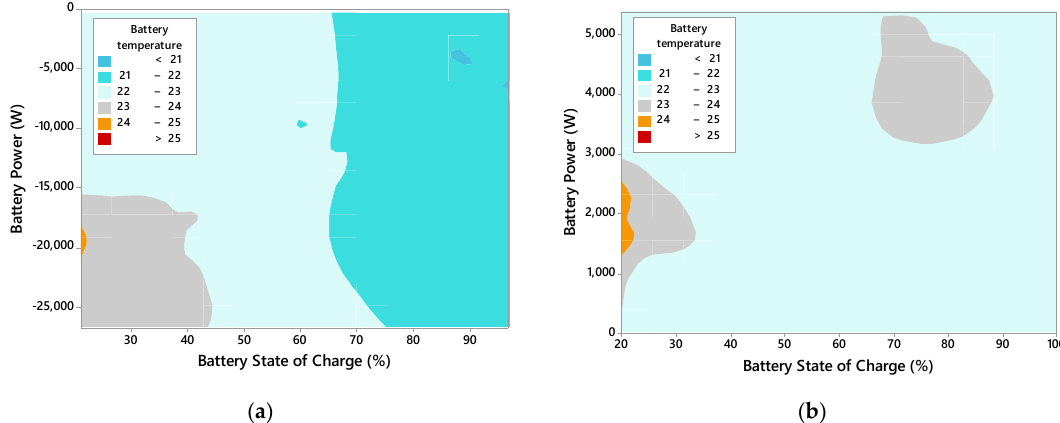
Figure 15. Temperature variation in function of batteries soc and power for: ( a ) discharging cycle and ( b ) charging cycle.